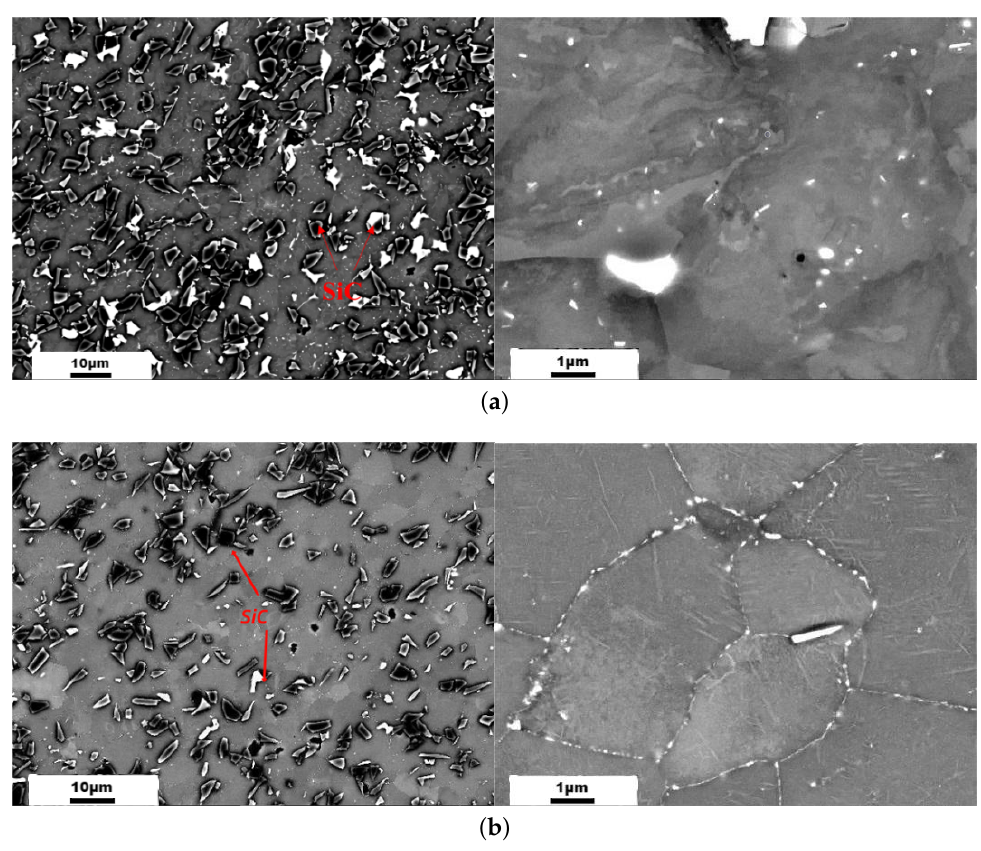
Figure 6. SEM images of SiCp–AA2009 composites with different scales under ( a ) initial state and ( b ) near peak-ageing state (20 h ageing) with CHT